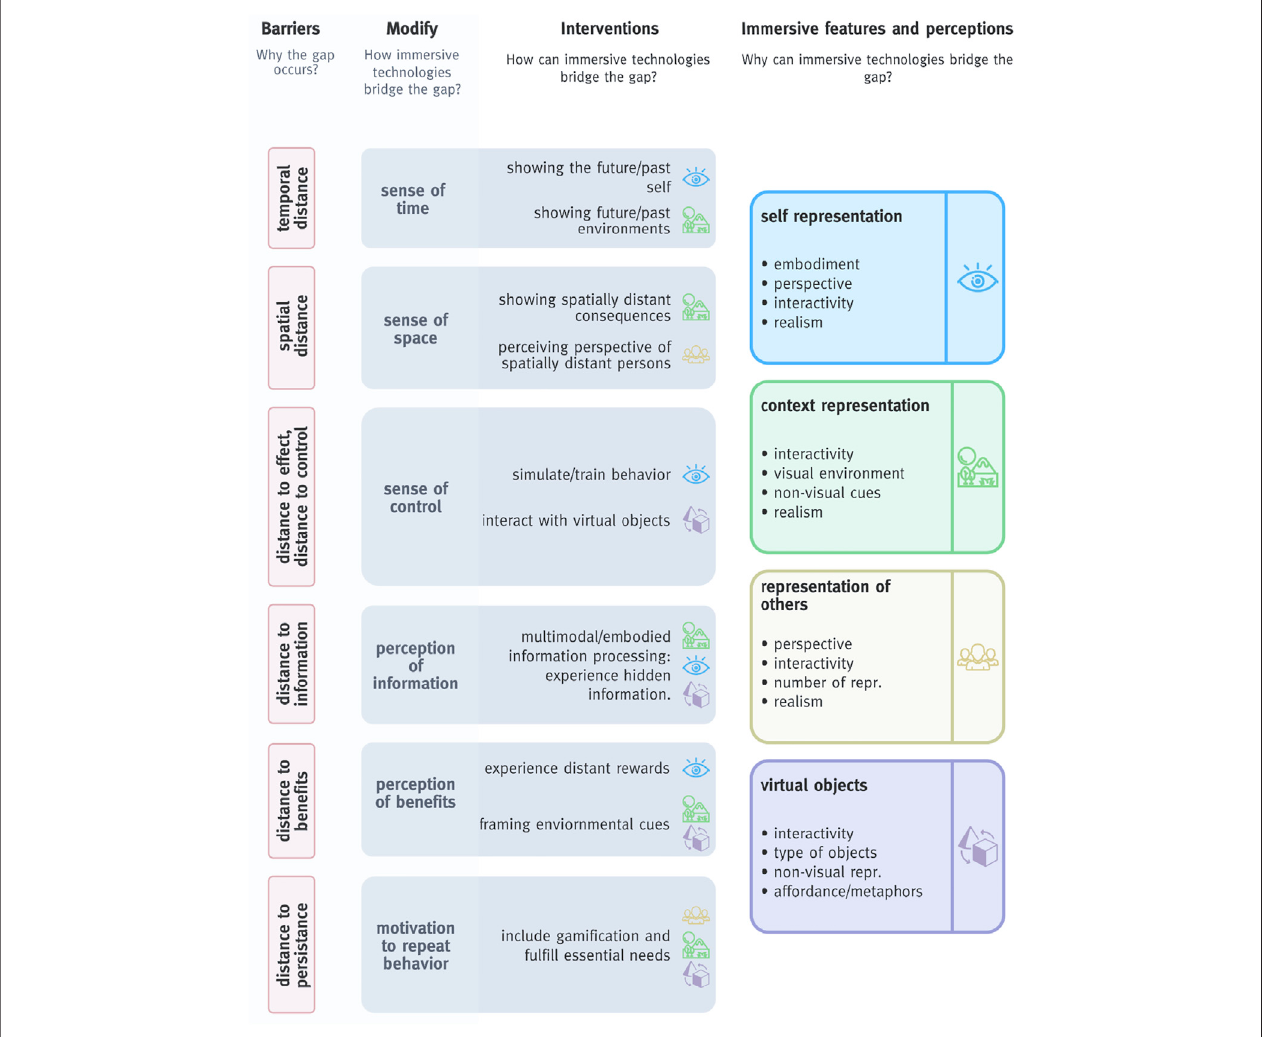
FIGURE 2 | Sums up the framework BehaveFIT explaining why and how immersive technologies support behavior change processes.